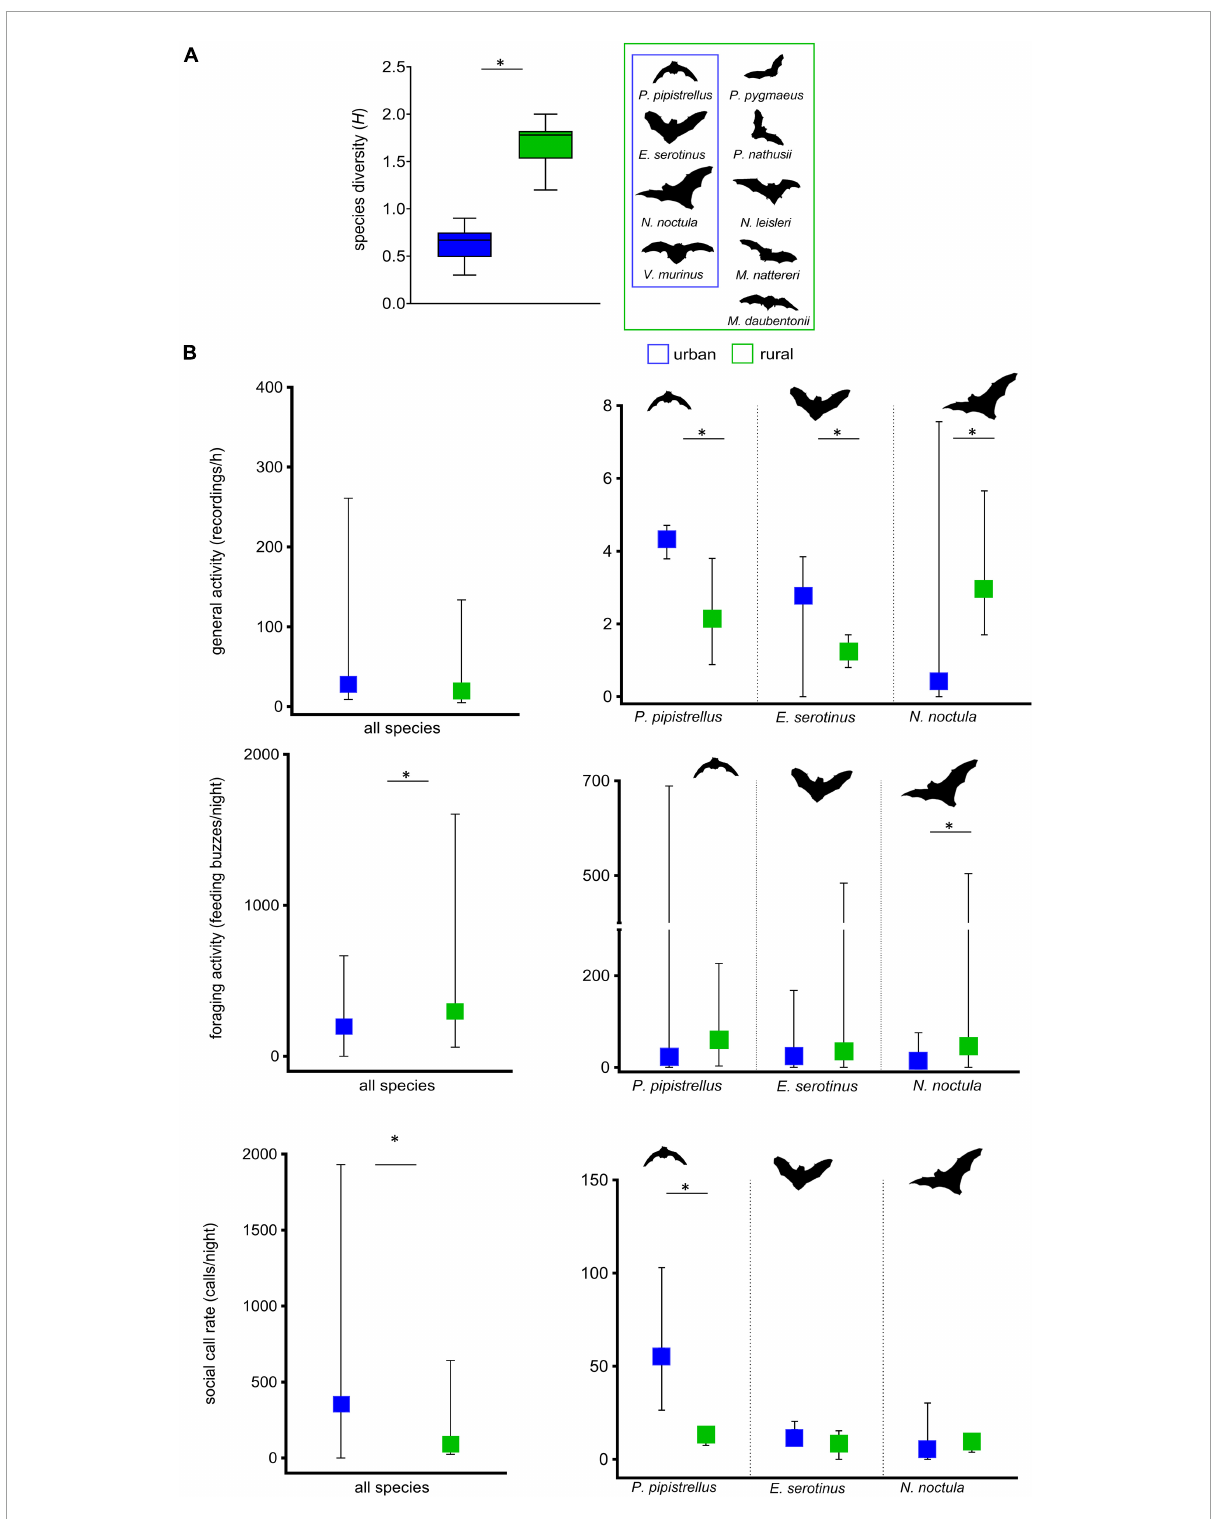
FIGURE1 Community-characterizing attributes and functional vocalization types on urban and rural study sites ( n = 162 paired sample nights). (A) Boxplots of species diversity as measured by Shannon’s H. (B) Overall and species-specific bat activity (recordings/h), foraging activity (feeding buzzes/night), and social call rate 1 (calls/night); medians are indicated by the center point of the boxes and interquartile ranges by the extent of the whiskers. 1 All social call types. ∗ P <